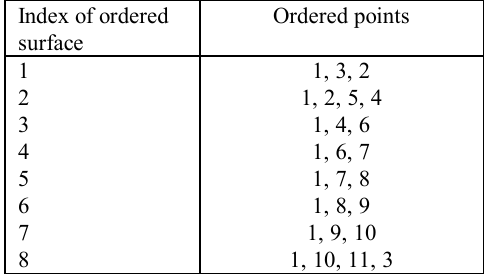
Table 12. Map structure with association of the index of the surface and the ordered indexes of the vertexes of this surface for Scenario